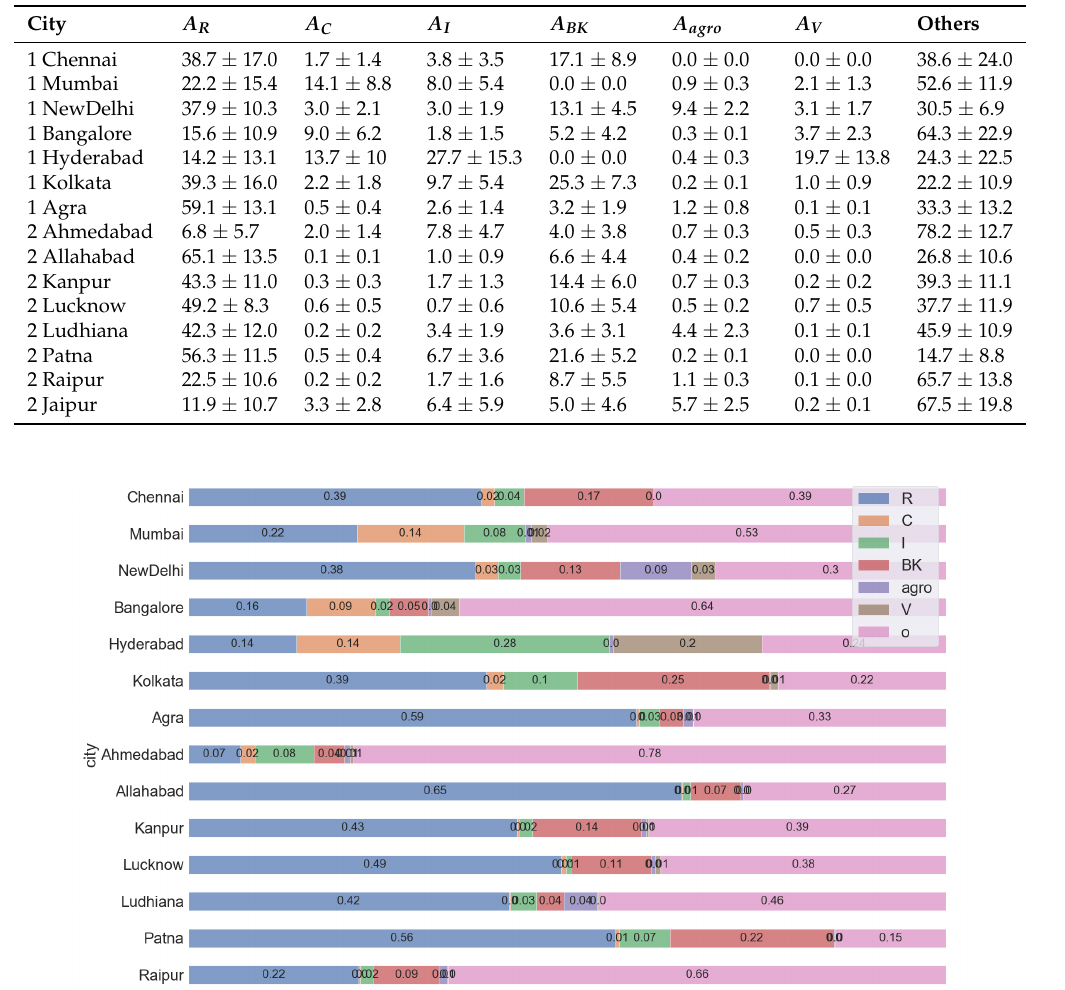
Table 5. Comparison of relative contribution to R est over the central grid cell from concentration due to primary emission from LU classes and other ( EA O ) is presented for for all the cities for the year 2015 and month November. The contribution is represented by residential ( A R ), commercial ( A C ), industrial ( A I ), agriculture related fires ( A agro ), brick kilns ( A BK ), vehicles ( A V ). Contribution to R est due to formation of secondary particles, meteorological transport and unaccounted sources is collectively labeled as